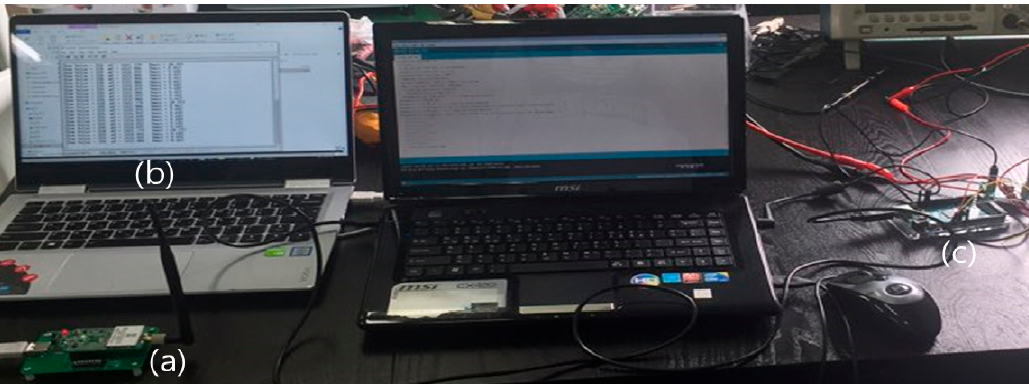
Figure 12. Drone load measurement by system: Communications -RF 424 MHz, -Transmission output 10 dBm, Receive Sensitivity − 124 dBm, Current Sensor: -ACS759, ~200 A/Micom: -Arduino Mega 2560. (The part labeled ( a ) is the receiver, ( b ) is the receiver data display, and ( c ) is the transmitter.).